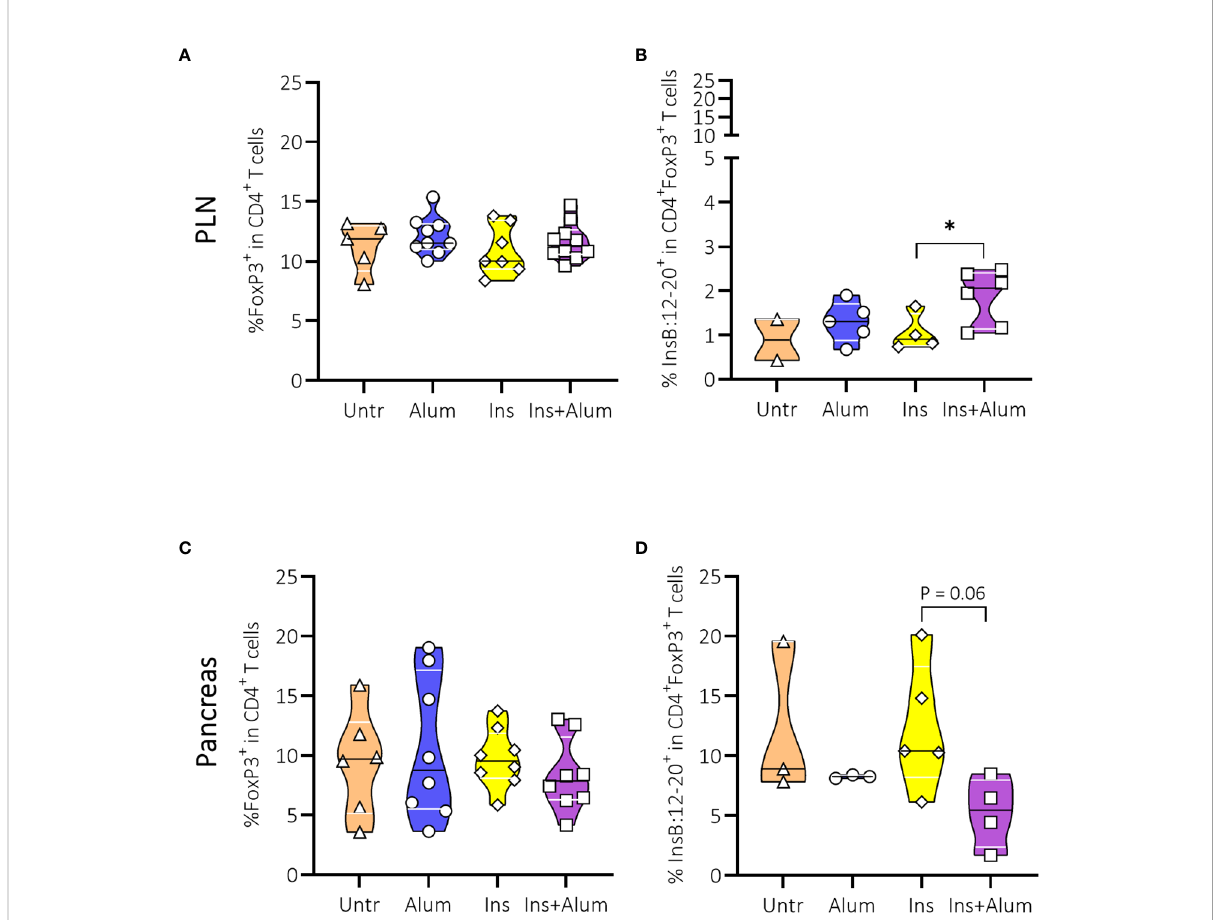
FIGURE 5 Effect of therapy on Foxp3 + Tregs and InsB:12-20-reactive FoxP3 + Tregs. Frequencies of FoxP3 + Tregs within the CD4 + T cell population (A, C) , and InsB:12-20-reactive cells within the CD4 + FoxP3 + T cell population (B, D) are shown at 15 weeks of age in the PLN and pancreas of NOD mice. Female NOD mice received four weekly subcutaneous injections, from 10 until 13 weeks of age, of InsB:8-24 peptide formulated in alum (Ins+alum), InsB:8-24 peptide dissolved in buffer (Ins), alum alone (alum), or left untreated (Untr). Data presented as median with interquartile range; symbols (n = 2-6) represent individual mice. *P ≤ 0.05; Treg, regulatory T cell; NOD, non-obese diabetic; PLN, pancreas-draining lymph